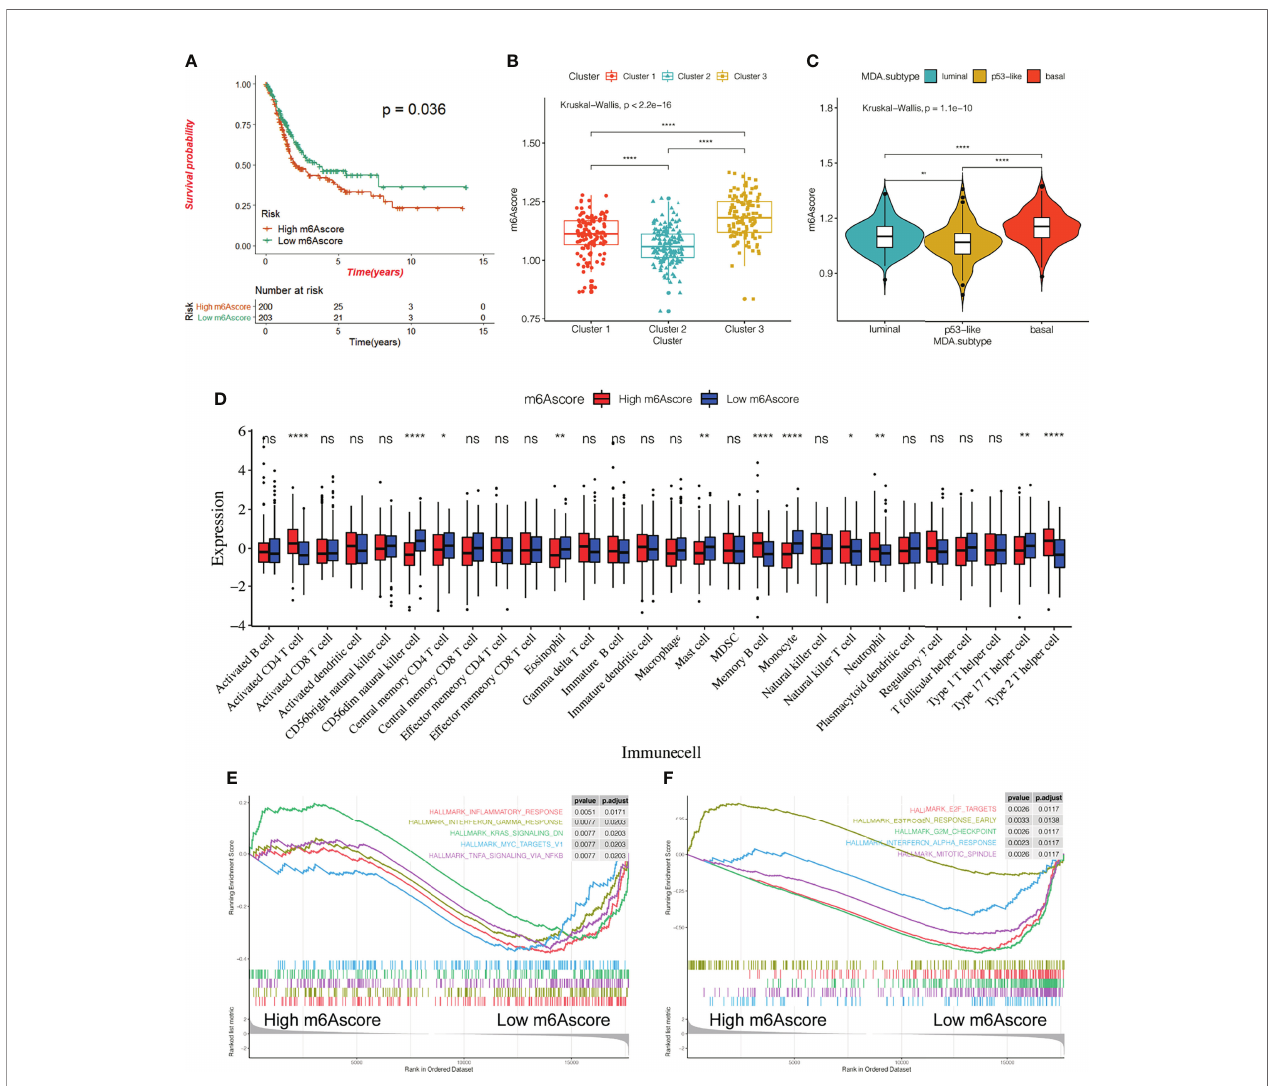
FIGURE 6 | Relationship between m 6 Ascore and the characteristics of bladder cancer. (A) KM survival curve showing the effect of m 6 Ascore on OS in the TCGA- BLCA cohort. (B, C) The difference of m 6 A score among three different m 6 A modi fi cation patterns (B) and MDA typing (C) . The asterisk represents the statistical p- value (*P < 0.05; **P < 0.01; ****P < 0.0001). (D) According to the expression of the m 6 Ascore,407 patients were classi fi ed into a high m 6 Ascore group and a low m 6 Ascore group. The histogram shows the expression difference of 28 kinds of immune cells between the two groups. (E, F) All transcripts were sequenced according to the multiple variations (log 2 ) obtained by the two groups in the analysis. GSEA analysis evaluated the skewness of the two distributions of the selected gene set in the sequenced gene